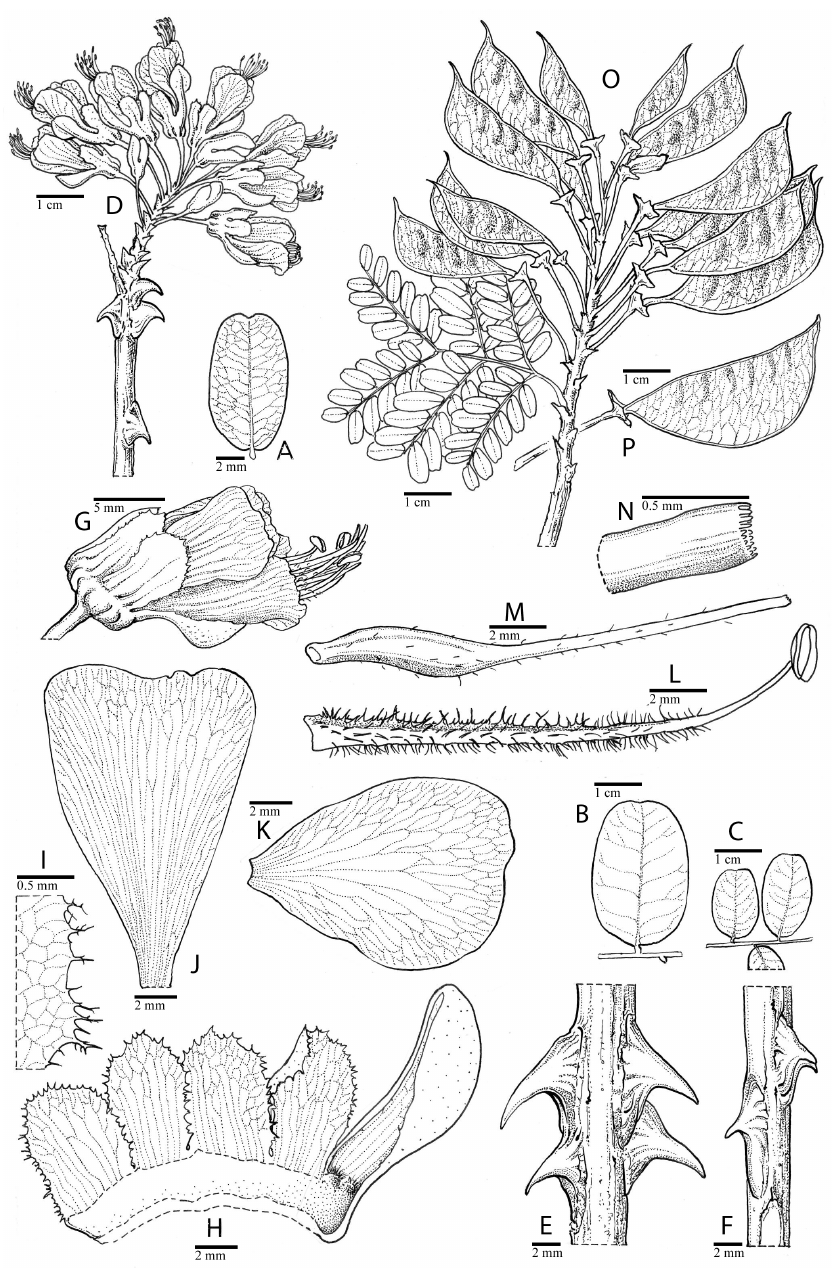
Figure 10. Caesalpinia cassioides Willd. A median leaflet B, C median leaflets (to show variation) D in- florescence E, F stem armature G flower H calyx opened out I calyx margin J median petal K upper lateral petal, L stamen M gynoecium N stigma O leaf and immature fruits P single immature fruit. A, D, E, Q from Mayolo 325 B, C, R from Silverstone-Sopkin 2004 F from Sandeman 4613 G–P from Silverstone-Sopkin 5139. Drawn by Sue